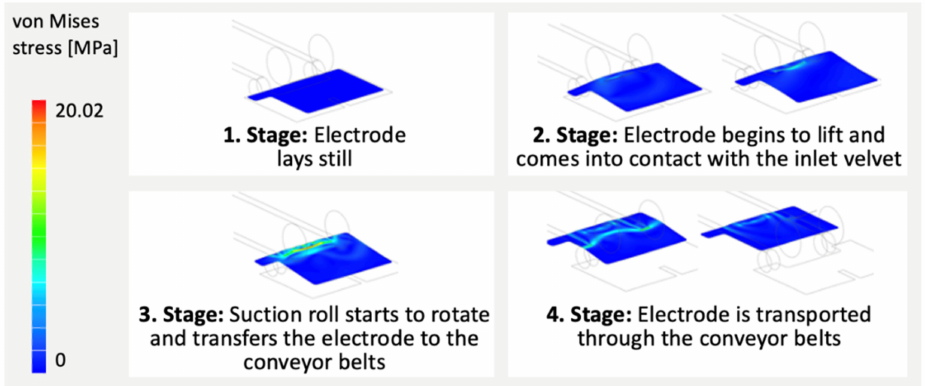
Figure 6. Stresses on the electrode are shown as a sequence for the separation module.